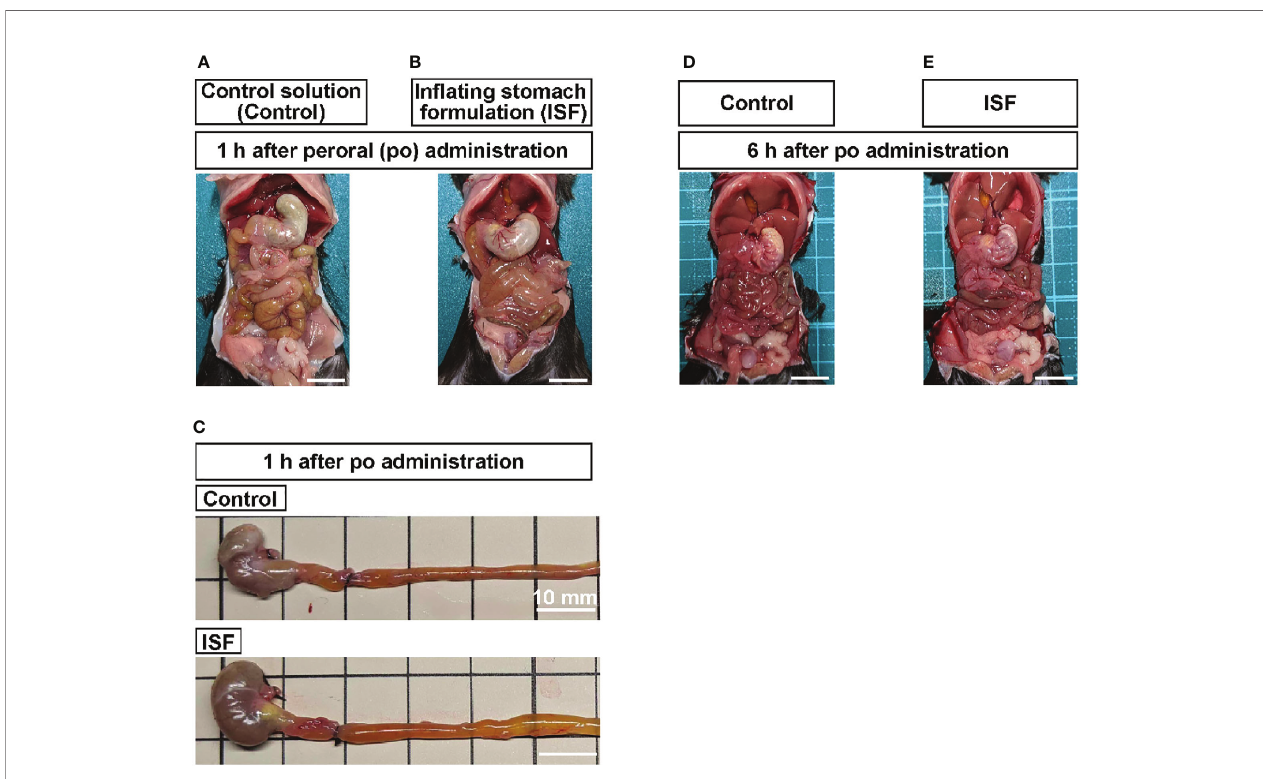
FIGURE 1 | Peroral (po) administration of in fl ating stomach formulation (ISF) induces distension of gastrointestinal tract in mice. (A, B) Gastric and intestinal distension at 1 h after po injection of control solution (30 ml/kg, A ) or ISF (30 ml/kg, B ) in mice fasted overnight. (C) Stomach and intestine collected at 1 h after administration. To maintain the distension, the gastric cardia, the joining part of common bile duct on the duodenum, and middle part of ileum were tied with black strings. (D, E) At 6 h after injection, ISF-induced distension of stomach and intestine returned to the control level. Scale bar indicates 10